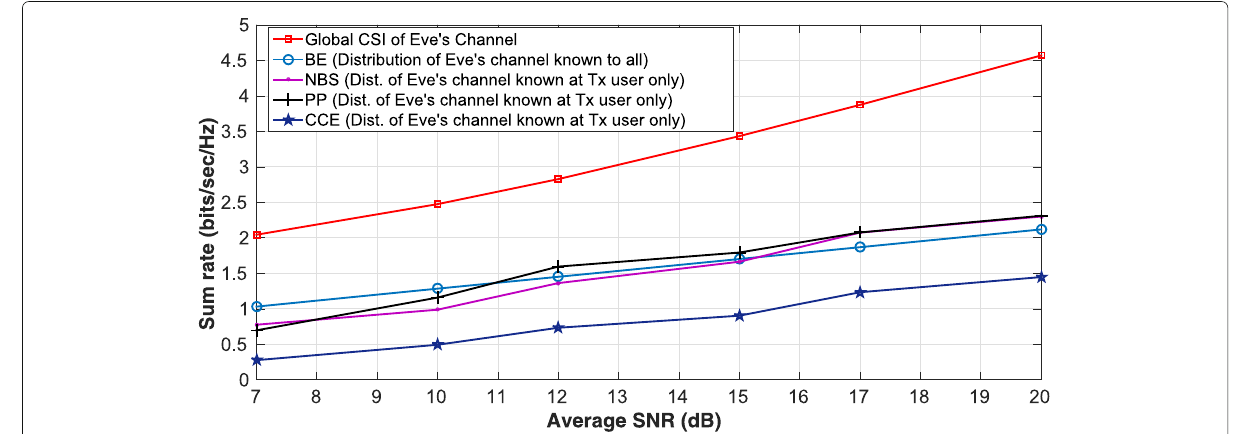
Fig. 12 F-MAC-WT: Comparison with existing schemes